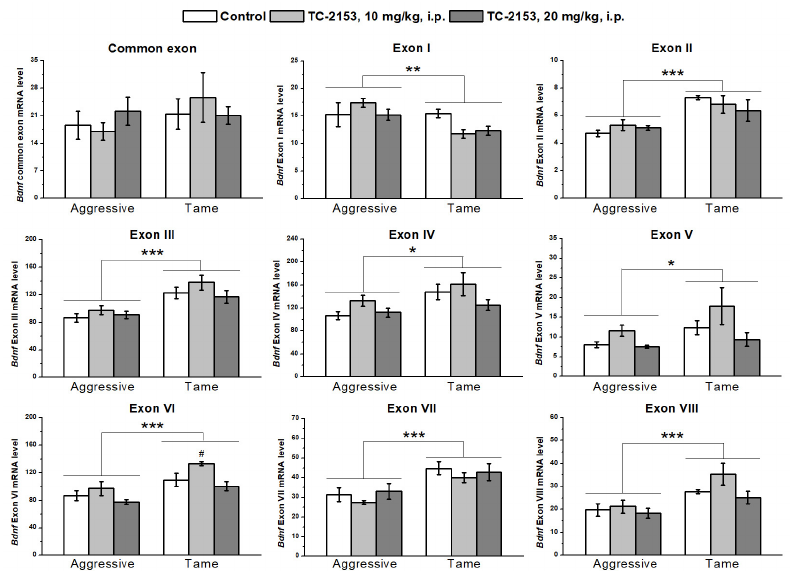
Figure 2. The impact of acute administration of vehicle (control) or TC-2153 at a dose of 10 or 20 mg/kg on mRNA levels of Bdnf (brain-derived neurotrophic factor) regulatory exons I–VIII and coding (common) exon IX in the hippocampus of aggressive and tame rats. The expression levels were evaluated as the number of transcript copies per 100 copies of Polr2a mRNA. * p < 0.05, ** p < 0.01, and *** p < 0.001 for the genotype effect; # p < 0.05 in comparison with the control group (5–7 animals per group).